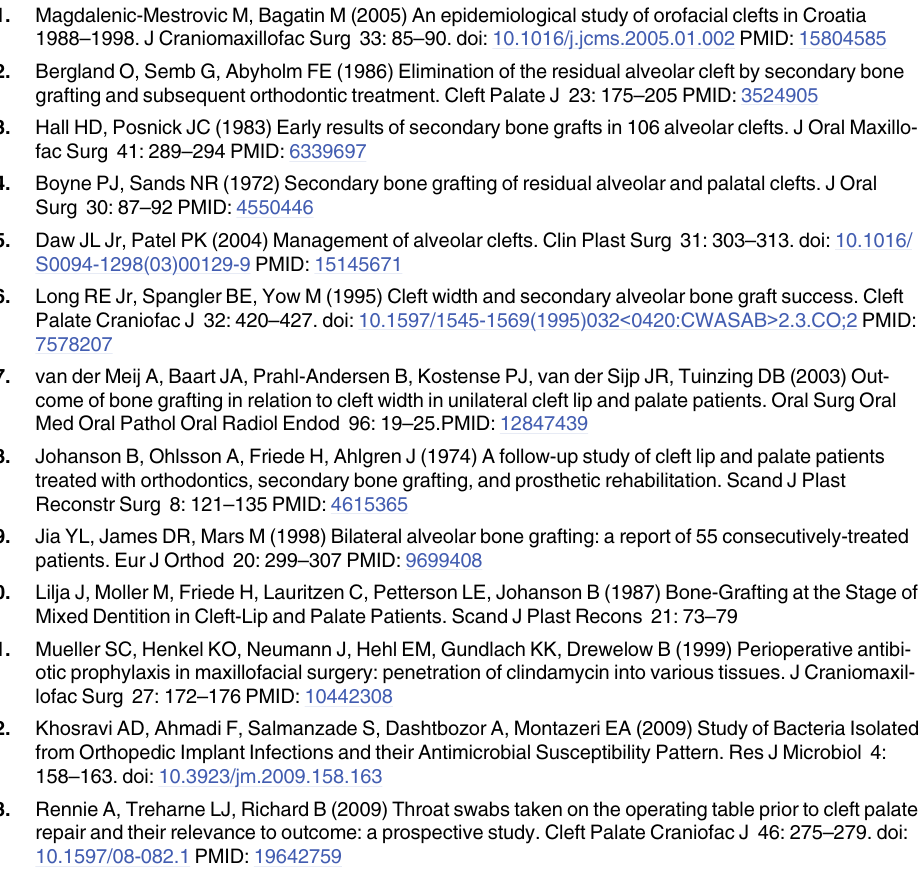
S2 Table. Detailed accuracy of the cross-validated random forest model based on the pre- operative OTUs. S3 Table. Classified results of the cross-validated random forest model based on the pre- operative OTUs. S4 Table. Microbial diversity estimators of the non-inflammation and inflammation groups before and after the